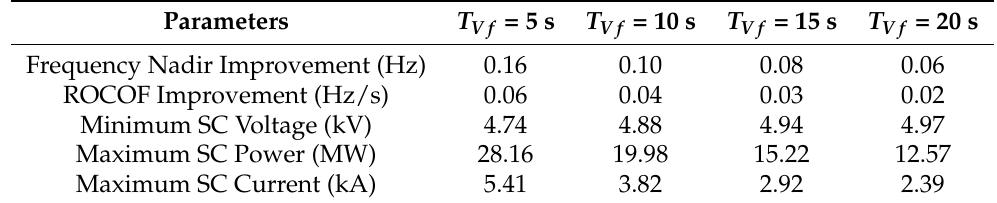
Figure 13. FFR provision from the directly connected SC with varying time constants (from top to bottom: system frequency, SC terminal DC voltage, SC output DC power, SC output DC current). Table 5. Overview of simulation results of FFR provision from the directly connected SC in systems with varying time